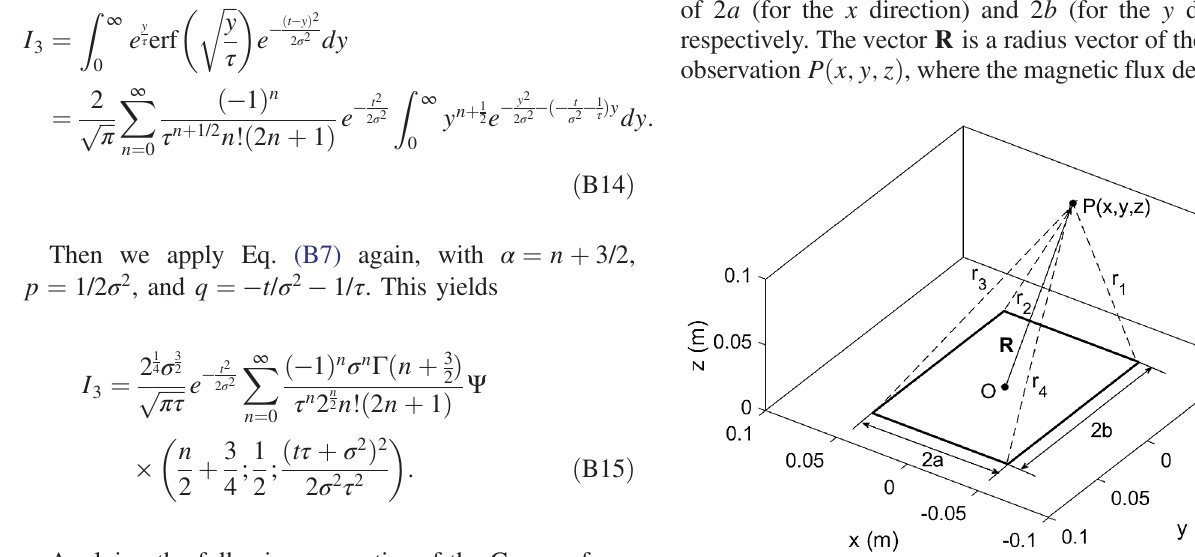
FIG. 25. Geometry of a single rectangular